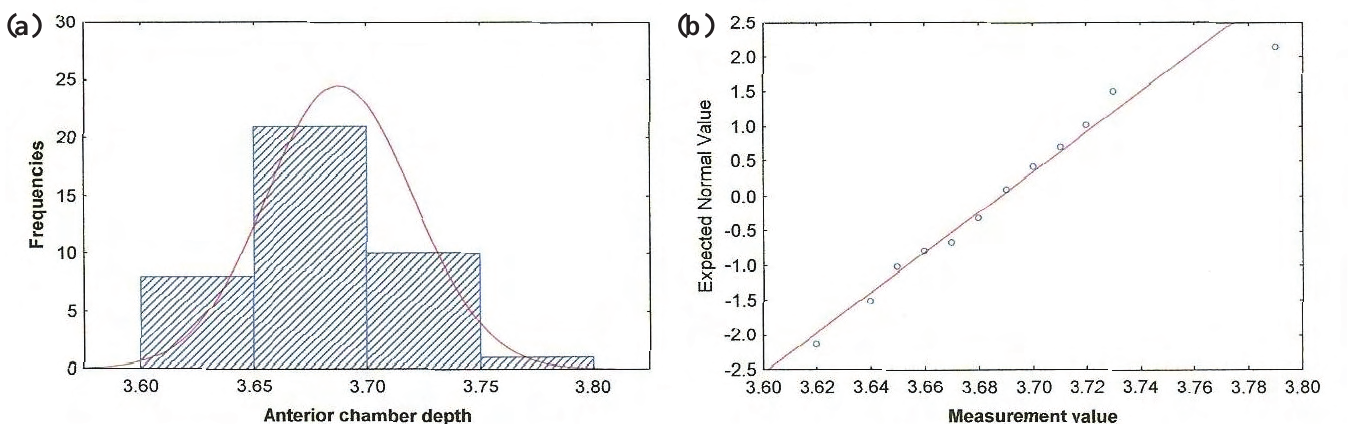
Figure 7. Histogram (a) and normal probability (b) plots for the AACD sample of subject 1. The sample was approximately normally distributed (the p -values for the K-S, Lilliefors and SW-W tests were all greater than 0.05). This suggests that the sample is regarded as being from a normally distributed population although a possible outlier is seen at the top of the normal probability plot (Table 2 indicates leptokurtosis of 1.277 and this quantity probably would be closer to zero should the possible outlier be